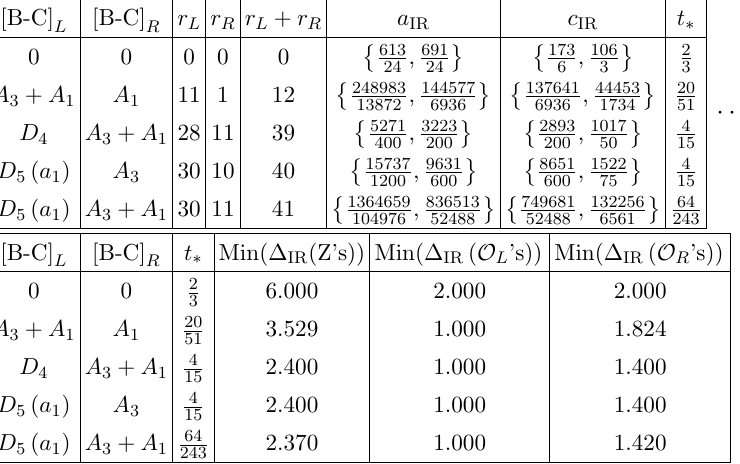
Table 21. Flipper (cid:12)eld deformations of ( E 6 , E 6 ) conformal matter, only rational values.